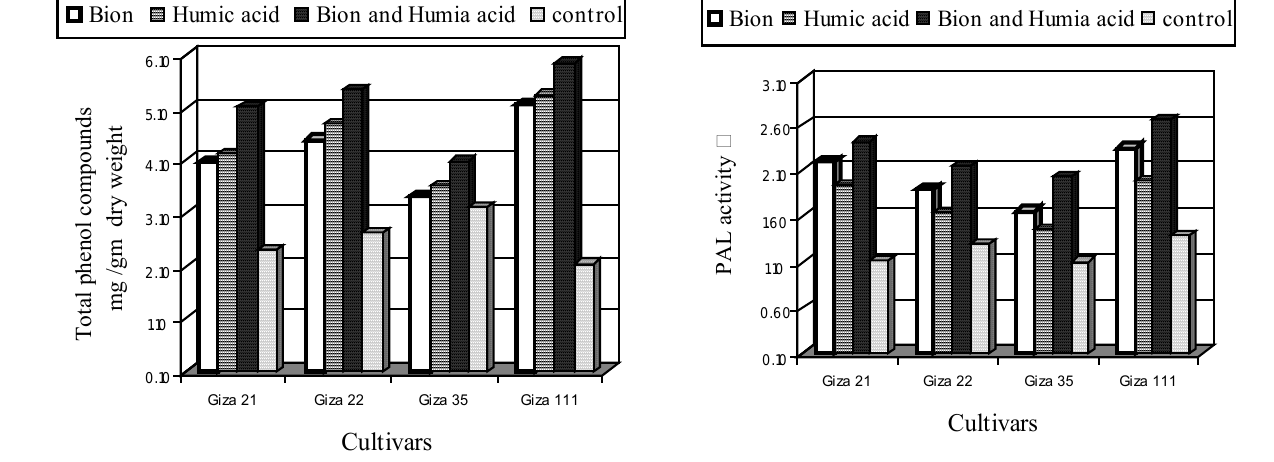
Fig. 4. Total phenol compounds (TPC) content of four soybean cultivars as affected by BHT (0.5 g/l), HA (4 g/l) individually or combination (0.25+4